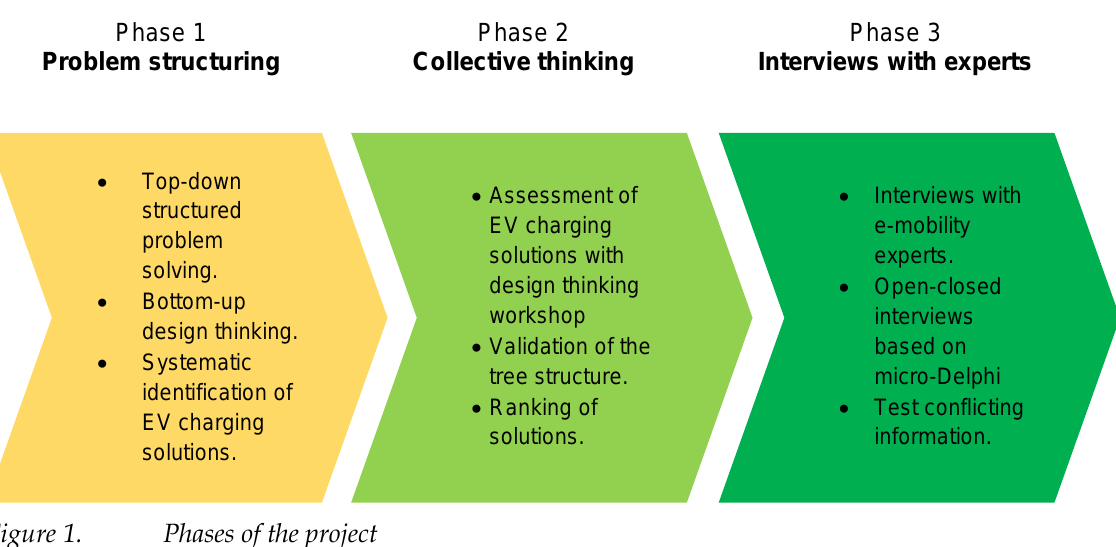
Figure 1. Phases of the project